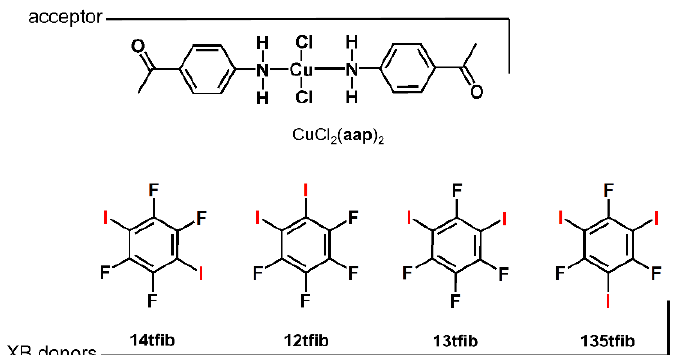
Figure 1. The halogen bond acceptor used in this study, a coordination compound derived from copper( II ) chloride and 4-aminoacetophenone, and halogen bond donors, perhalogenated benzenes.